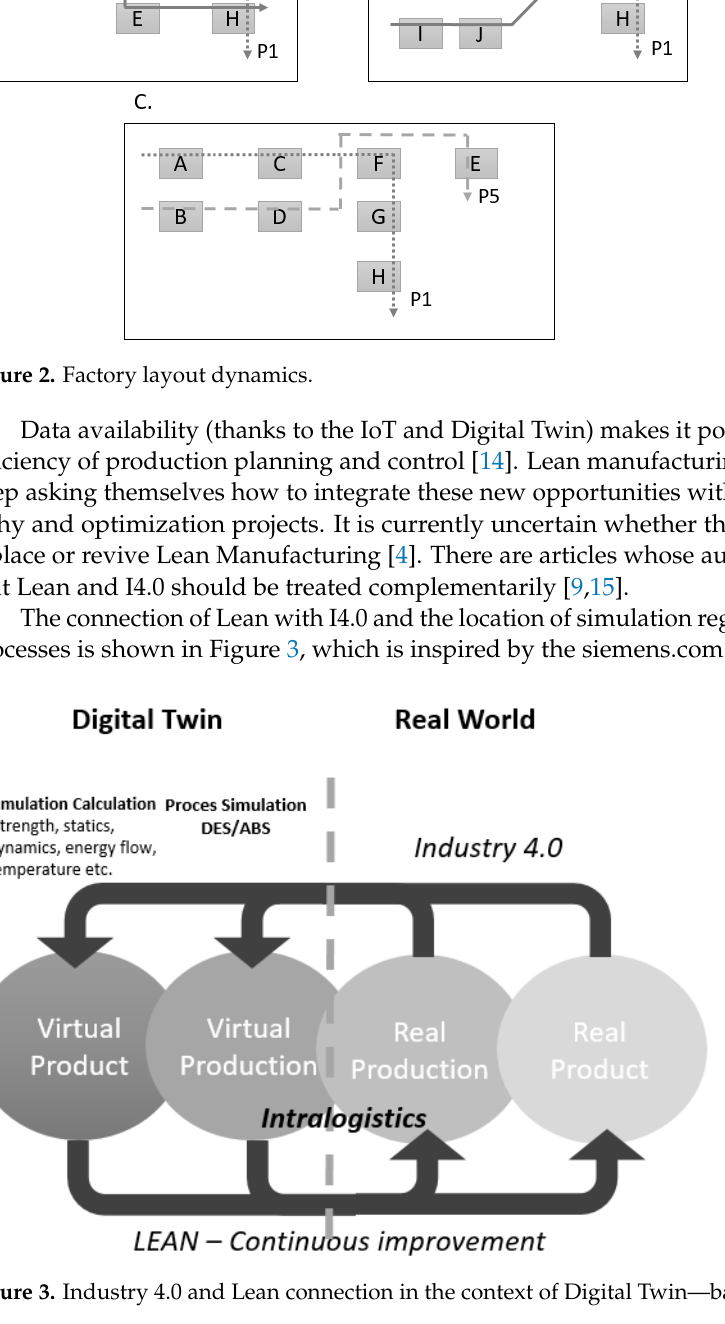
Figure 2. Factory layout dynamics.